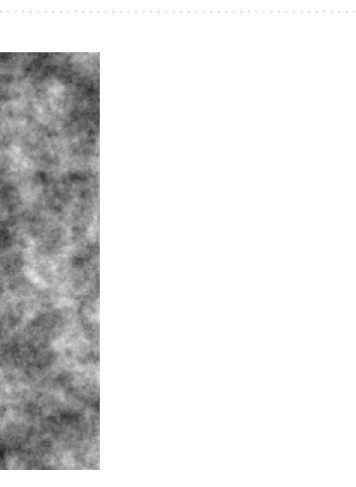
Figure 11. FS images of 8-bit grayscale with fractal dimension of 2.5. ( a ) 281 × 1000 pixels and ( b ) 1000 × 1000